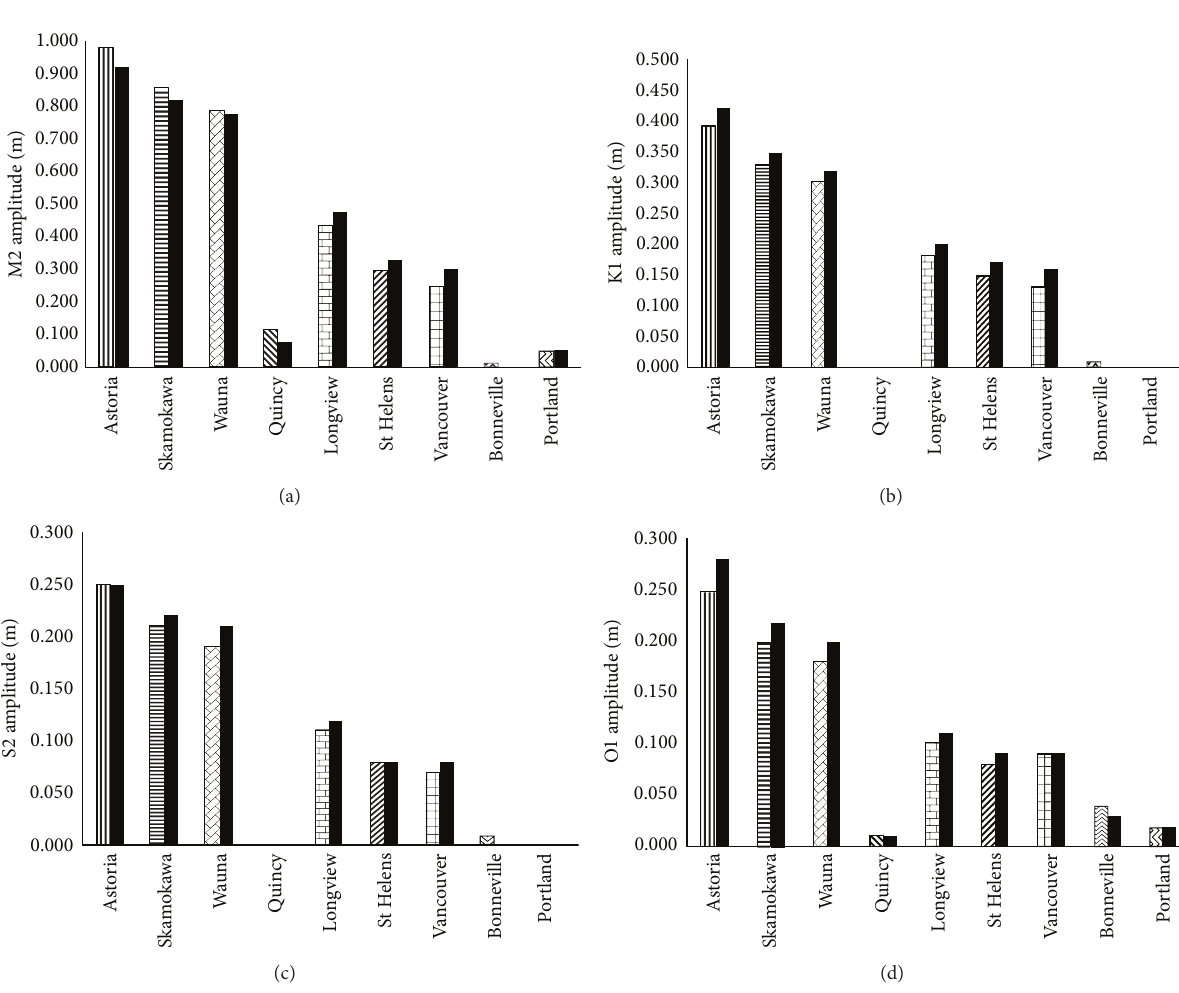
Figure 9: Amplitudes (a) M2, (b) K1, (c) S2, and (d) O1 (hatch is model, solid is field).